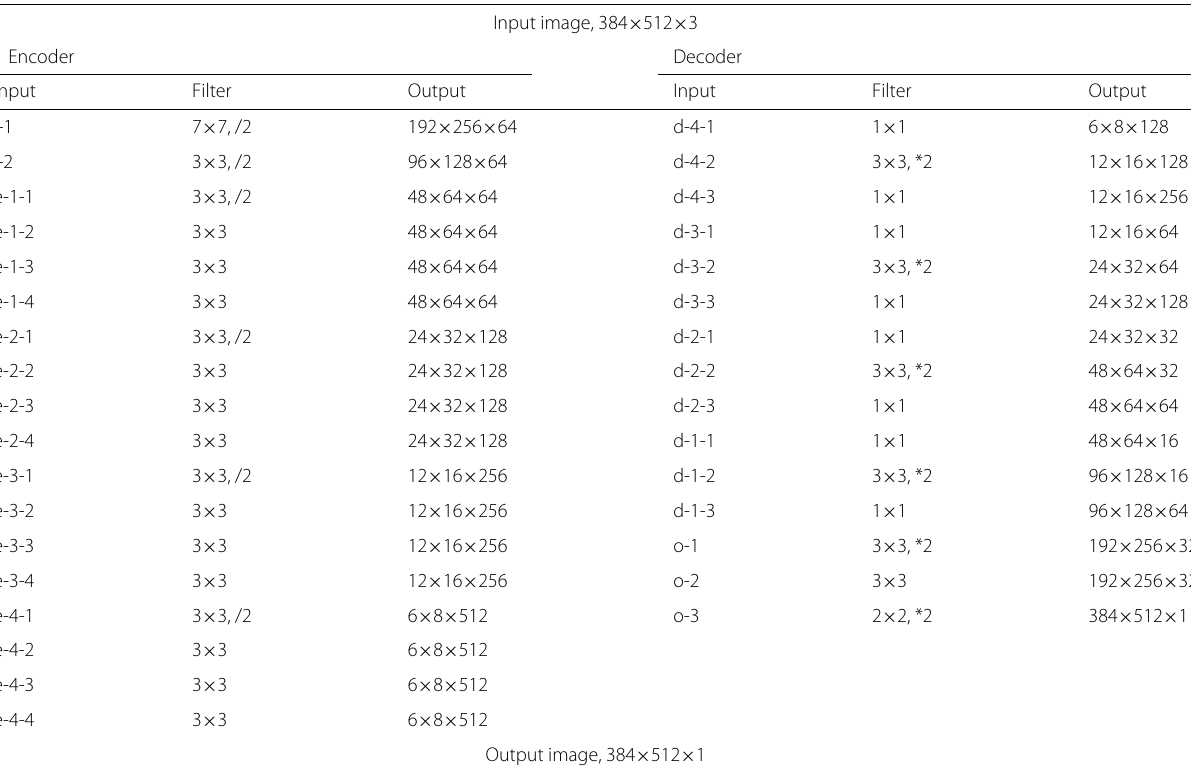
Table 1 Architectural details of the proposed